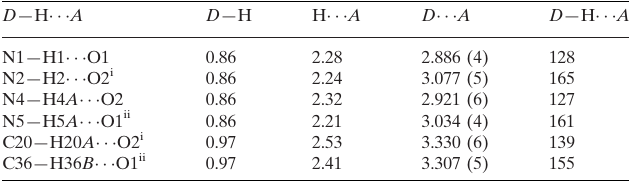
Hydrogen-bond geometry (A˚ , (cid:2)